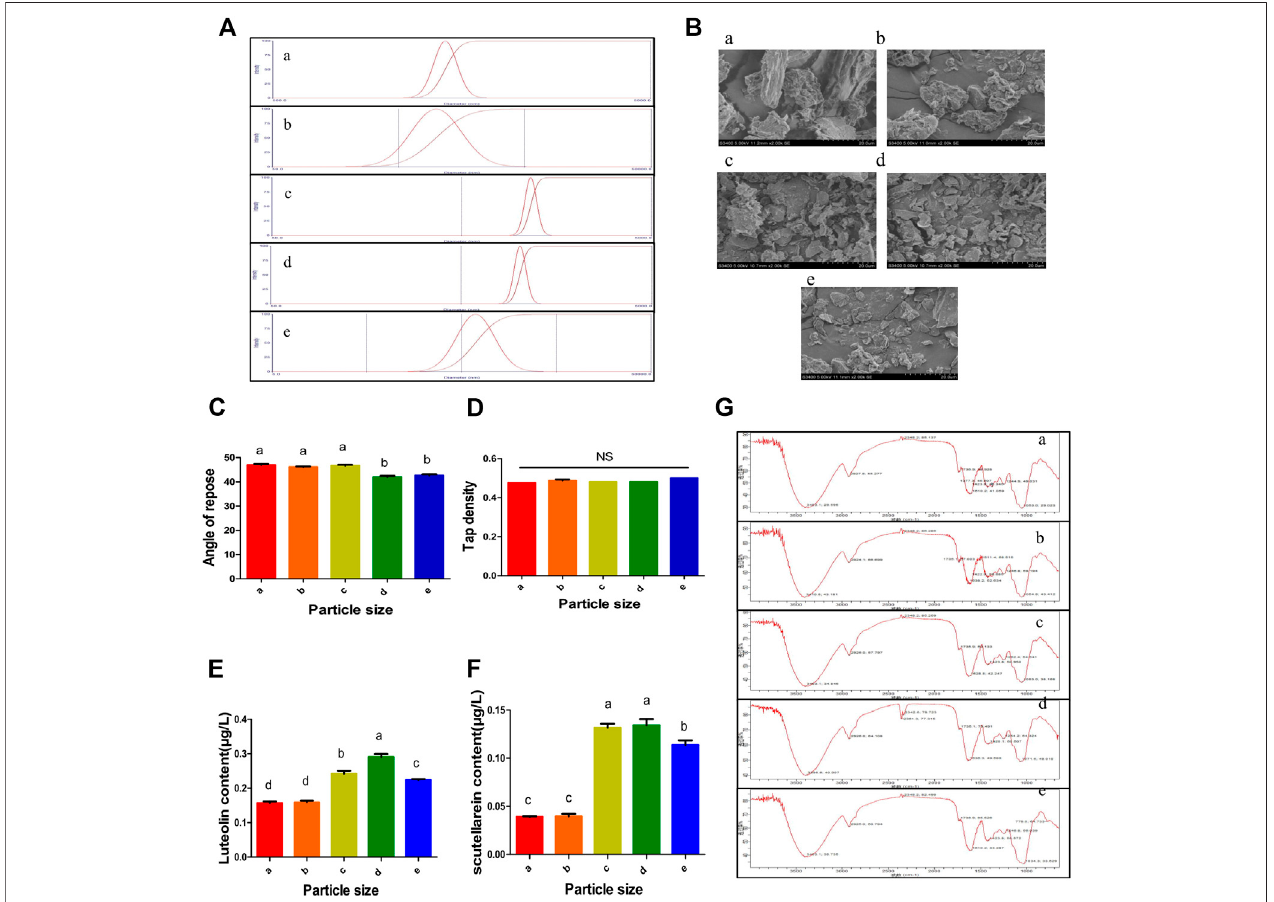
FIGURE 5 | Evaluation of different characteristics of PSP. (A) The particle of different PSPs was determined by laser diffraction instrument. α - ε represents the particle size distributions of fi ve different kinds of PSPs, respectively. (B) Different sized PSP powders were observed by 2,000 × SEM. The particle size of PSP was graduallydecreasedfrom α to ε . (C,D) TheangleofreposeandtapdensityofdifferentparticlesofPSPweredetermined. (E,F) Thecontentofluteolinandscutellarein. (G) The PSP with different particles was determined through Fourier infrared spectroscopy. The numbers in the picture represent the peak absorption of each functional group in the PSP. All data are presented as means ± SD from fi ve groups. Different small letter superscripts (a – e) in the same column indicate signi fi cant differences at p < 0.05.